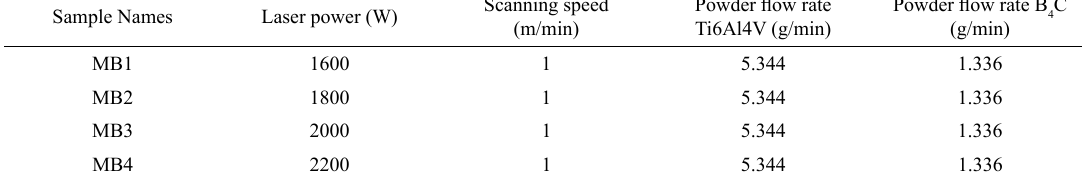
Table 3. Experimental matrix.